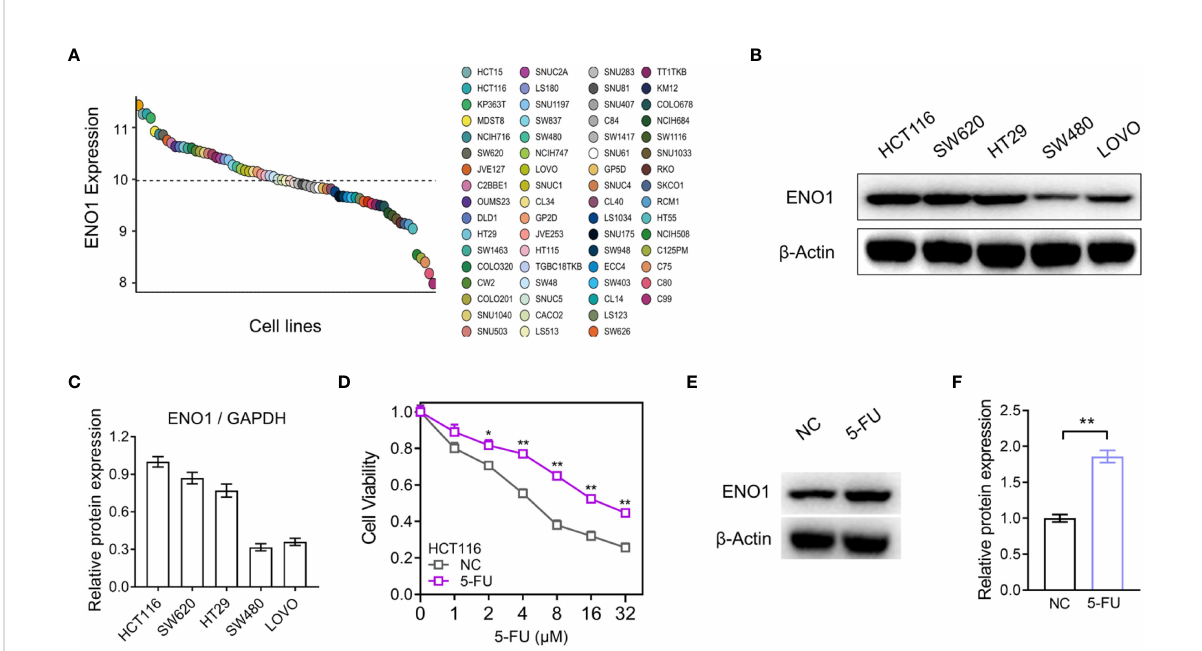
FIGURE 3 ENO1 expression was increased in the constructed 5- fl uorouracil (FU)-resistant cells. (A) Comparison of ENO1 expression between various CRC cell lines in Cancer Cell Line Encyclopedia (CCLE). (B, C) Immunoblotting results of ENO1 (B) in cell lines HCT116, SW620, HT29, SW480, and LOVO and quantitative counting (C) . (D) Cell viability comparison between HCT116 cells and 5-FU-resistant cells. (E, F) Increase in ENO1 expression (E) in 5-FU-resistant cells and the statistical graph (F) . Statistical analyses were performed via two-tailed Student t test. *,P ≤ 0.05; **, P ≤